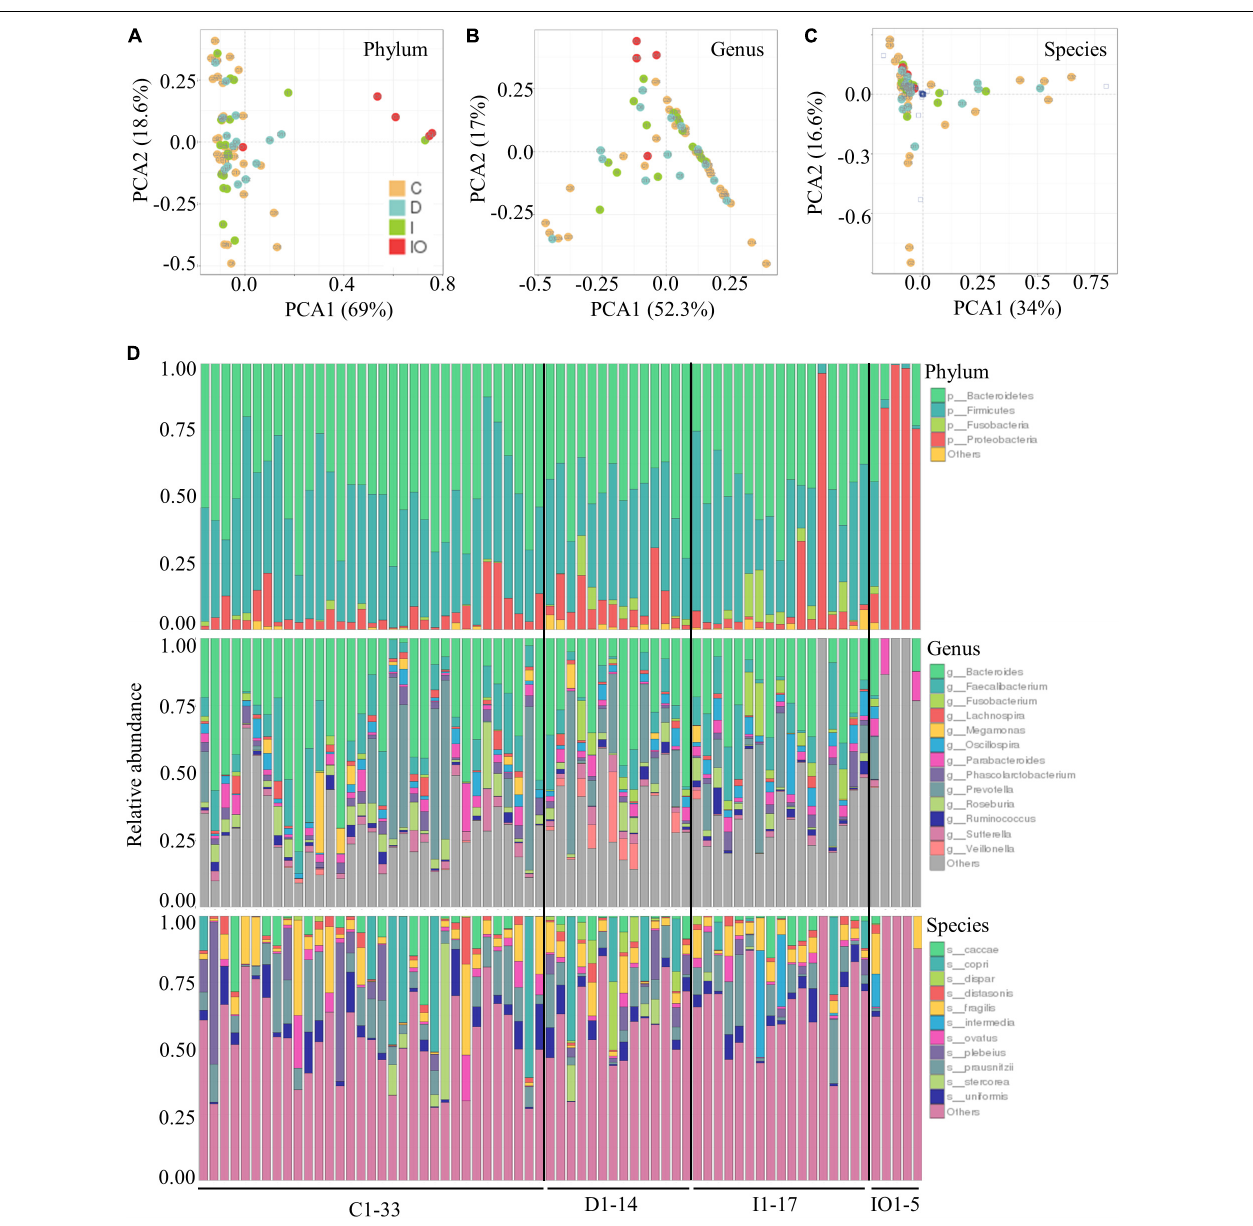
FIGURE 3 | Relative abundance of the bacterial phyla, genera and species in each clinical group. PCoA at the phyla (A) , genera (B) , and species (C) levels for all clinical groups. (D) Relative abundance of the annotated OTUs for all of the samples tested in this